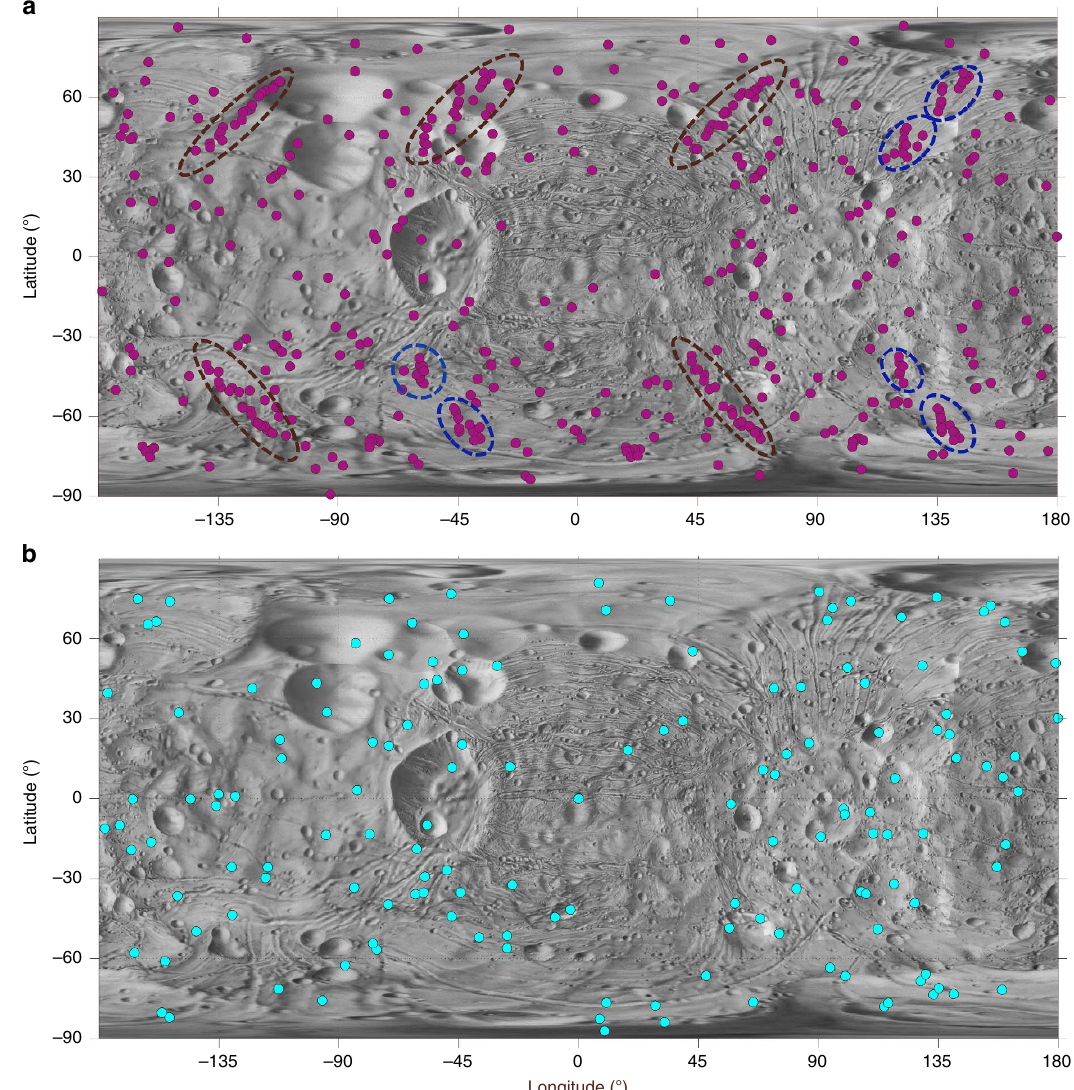
Figure 1 | Reaccretion map for the Stickney impact in Phobos modern and primordial orbits. ( a ) Ejecta from Phobos in its modern orbit, a B 2.77 R Mars ; multiple linear strings of reimpacts are noted in both hemispheres (brown and blue ellipses). ( b ) Ejecta from Phobos in its primordial orbit near the Mars synchronous line, a B 6 R Mars ; similar reaccretion patterns are not seen. All ejection velocities range from 11 to 100ms (cid:3) 1 , azimuth b A [0: p /6:2